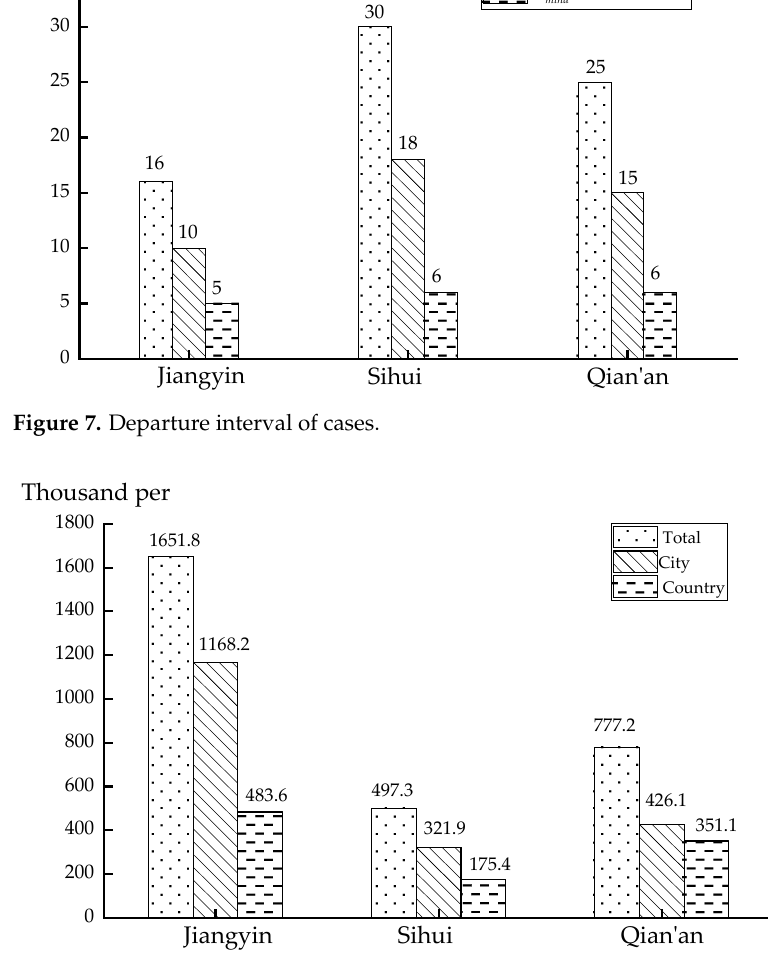
Figure 7. Departure interval of cases.